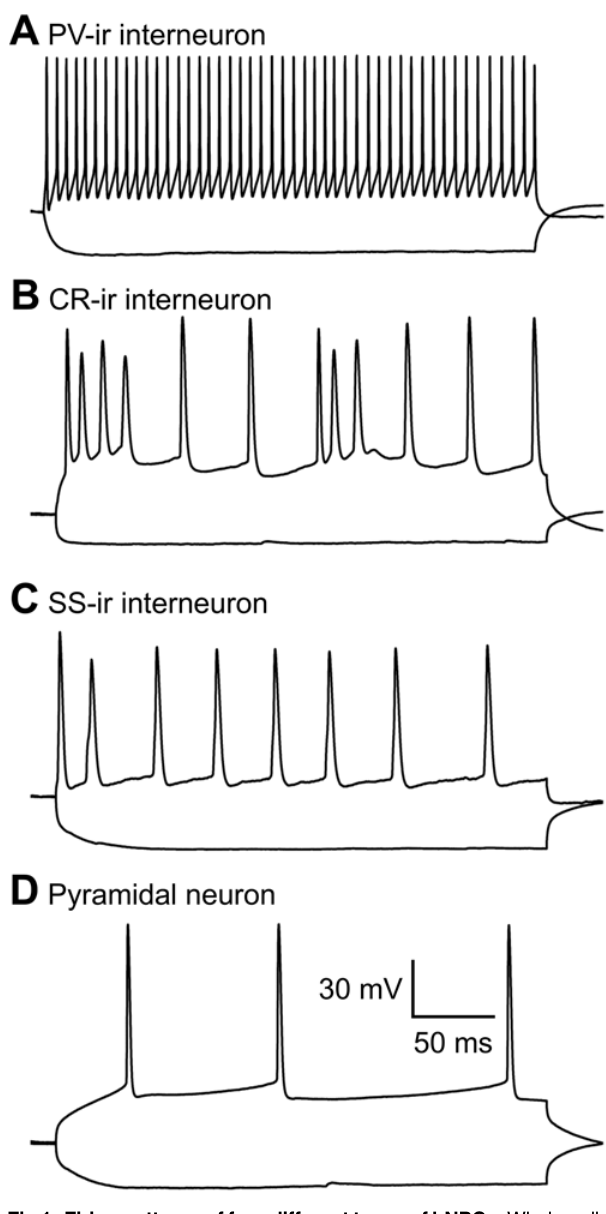
Fig 1. Firing patterns of four different types of hNPCs. Whole-cell current-clamp responses to injection of depolarizing (300 ms, +250 pA) and hyperpolarizing (300 ms, − 250 pA) current pulses. Depolarizing current induced firing activity with different frequencies and patterns in 4 subtypes of hNPCs. In response to depolarizing current, PV-ir cells fired at high frequency without any adaptation (A); CR-ir cells fired with an irregular firing pattern (B); SS-ir cells fired at lower frequency with adaptation (C), and pyramidal neurons fired at the lowest frequency with obvious adaptation. The calibration bar in D also applies to A, B and C.